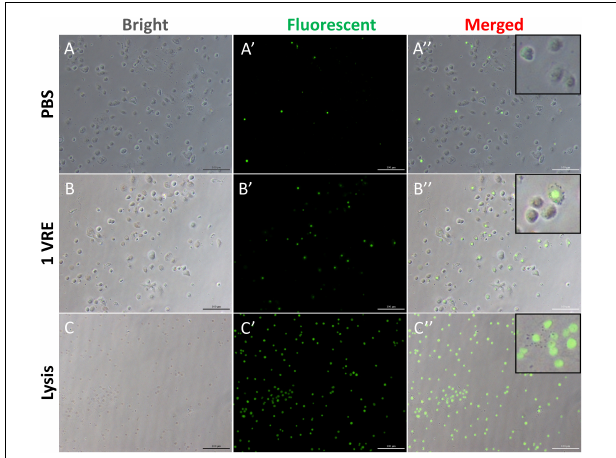
FIGURE 2 | Cell viability assay after venom treatment. The hemocytes were incubated with PBS (A–A (cid:48)(cid:48) ) , 1 VRE (B–B (cid:48)(cid:48) ) , and lysate (C–C (cid:48)(cid:48) ) followed by microscopic examination under white, fluorescent, and merged view, respectively. Fluorescently labeled cells represent dead cells.